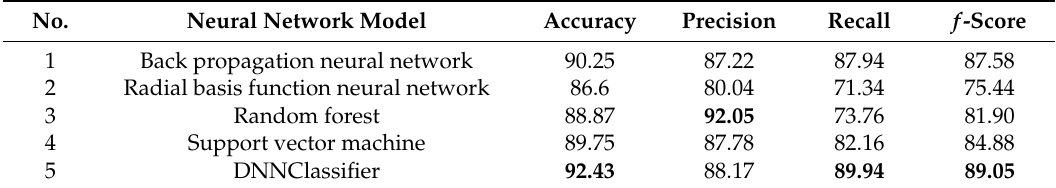
Table 3. Comparison of various models (%).